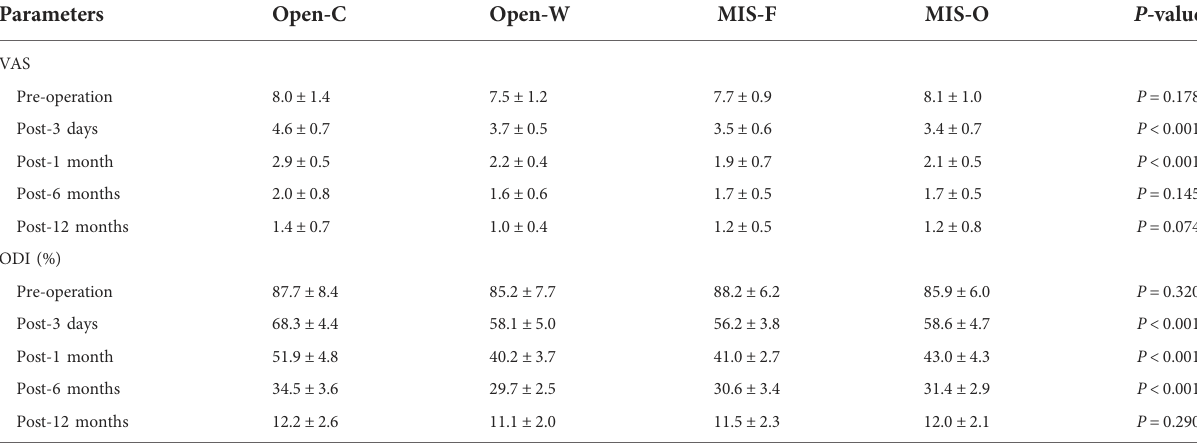
TABLE 3 VAS and ODI scores before operation and at different follow-up times of the four groups.